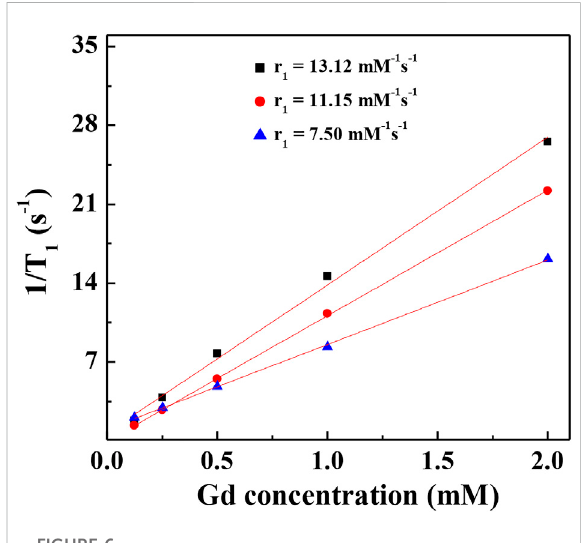
FIGURE 6 Linear fi tting 1/T 1 of (Au 0 ) 50 G5.NHAc- m PEG-DOTA 30 (Gd) (black square), (Au 0 ) 75 G5.NHAc- m PEG-DOTA 30 (Gd) (red circle), and(Au 0 ) 100 G5.NHAc- m PEG-DOTA 30 (Gd)(bluetriangle)DENPsat Gd concentrations of 2, 1, 0.5, 0.25 and 0.125 mM.